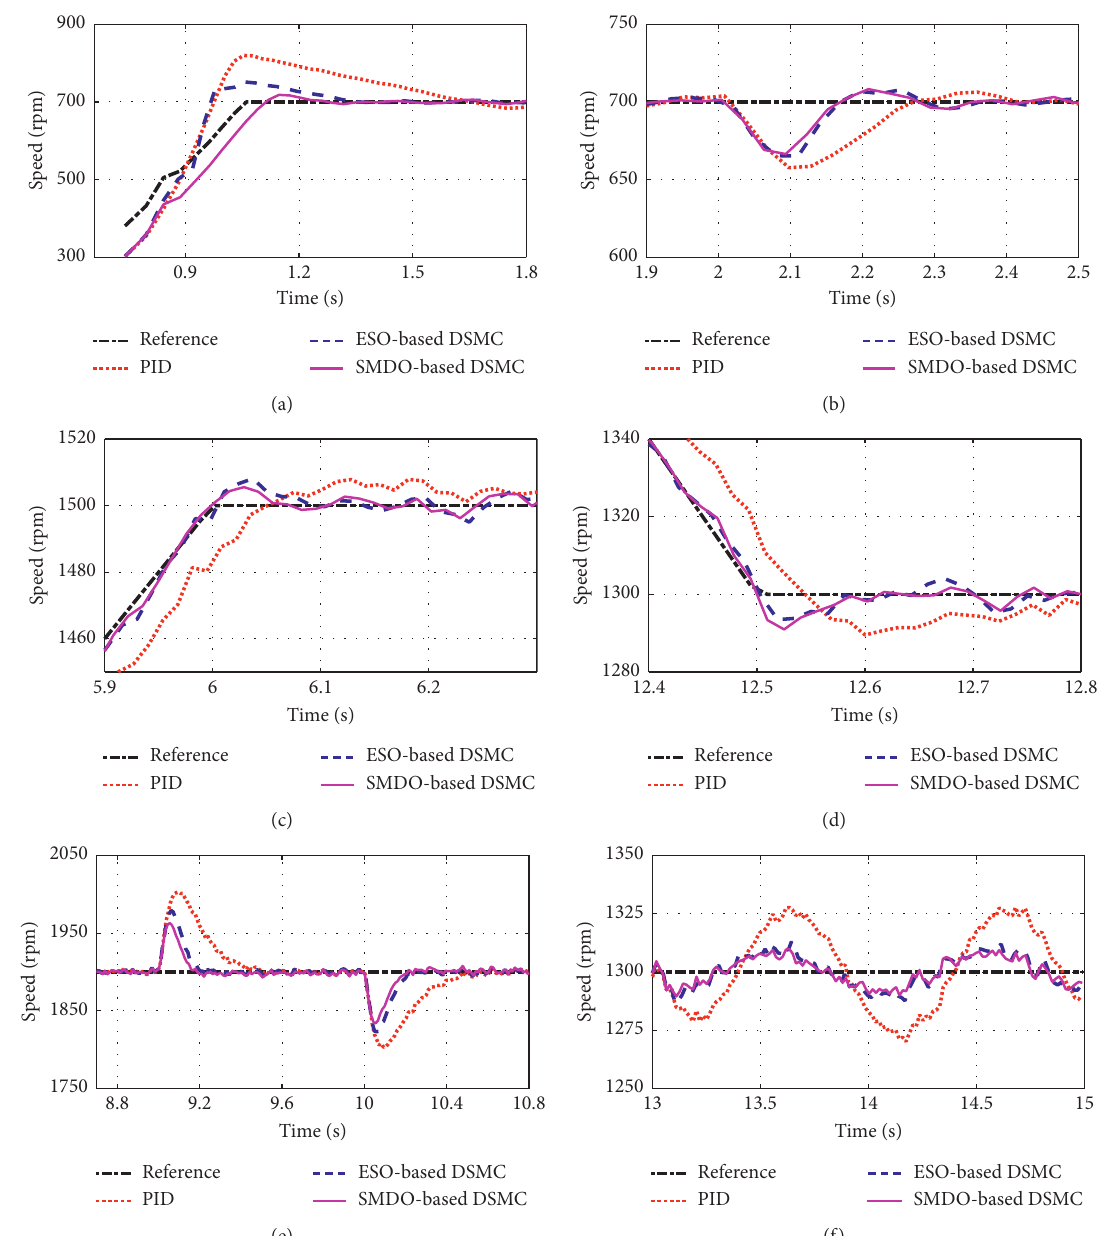
Figure 13: The control performance comparison between the controllers with different moment of inertia. (a) The starting process. (b) The first loading process. (c) Acceleration process. (d) Deceleration process. (e) The sudden loading and unloading process. (f) The periodic disturbance